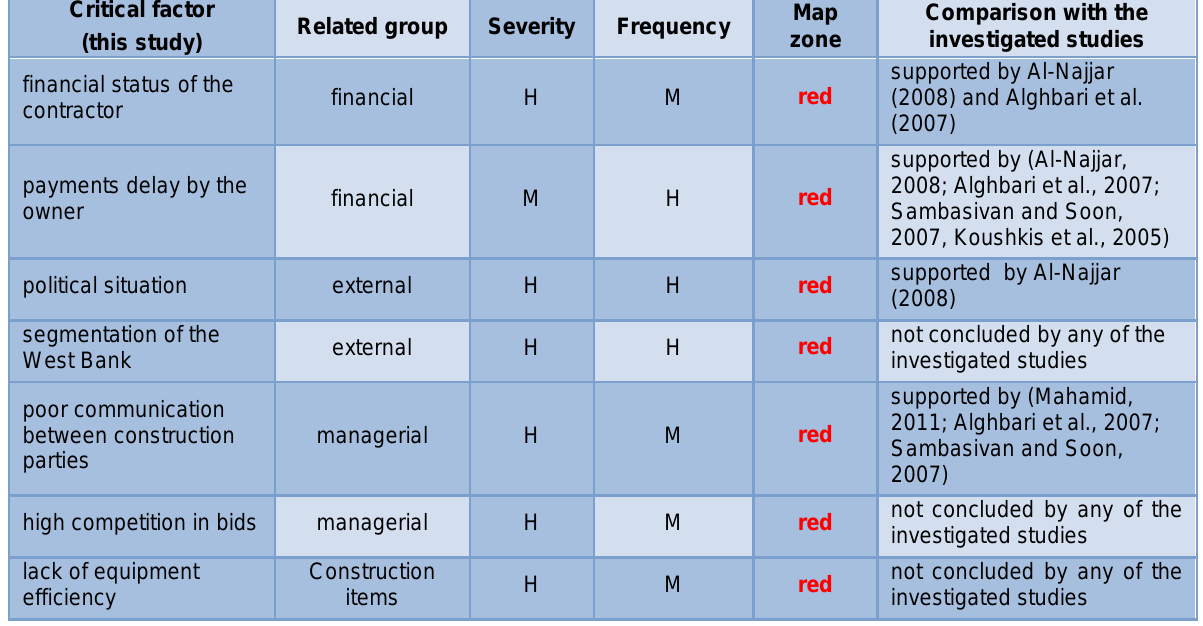
Table 8 Critical factors of this study and comparison with the investigated